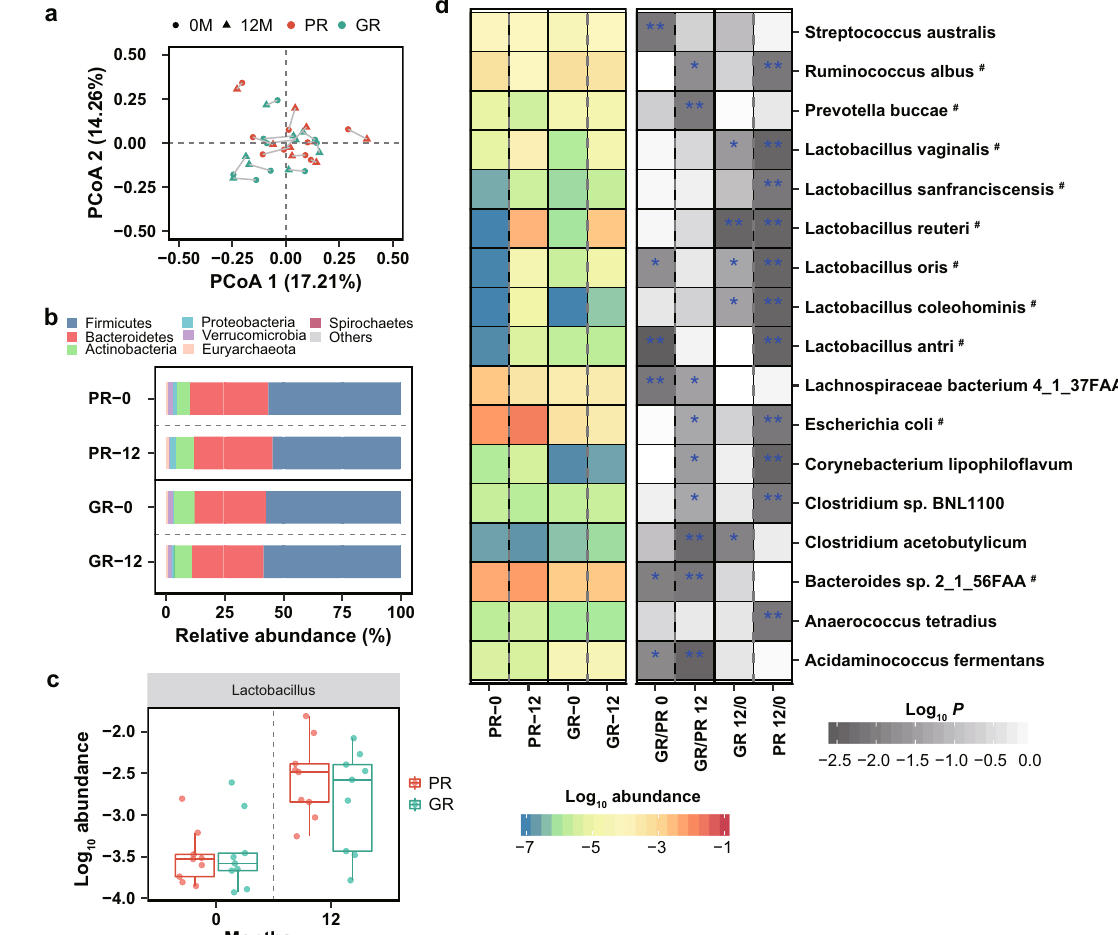
Fig. 2 Compositional differences of the gut microbiota after supplementation with L. reuteri ATCC PTA 6475. a Principal coordinate analysis (PCoA) of microbiota community at species level based on Bray – Curtis distance. The overall microbial composition between the GR ( n = 9) and PR ( n = 9) groups or between the two time points shows no signi fi cant difference, estimated by PERMANOVA analysis. The blue and red colors indicate the GR and PR groups, respectively; The dot and triangle indicate the baseline (0 M) and 12 months (12 M), respectively. b Relative pro fi les of top seven abundant phyla. c Increased abundance of the genus Lactobacillusin in the GR ( n = 9) and PR ( n = 9) groups at 12 months ( P- value < 0.01 by the Wilcoxon signed-rank test). The upper quartile, median and lower quartile are shown in the box plot. The blue and red colors indicate the GR and PR groups, respectively. d The left heatmap shows log-transformed mean abundances of differential species in the two groups at the two time points. The blue and red colors indicate the low and high abundances, respectively; The grey color in the right heatmap indicates P -value of comparative analysis using the Wilcoxon test ; ‘ * ’ denotes P < 0.05; ‘ ** ’ denotes P < 0.01; ‘ # ’ indicates the differential species were also identi fi ed by DESeq2 (adjusted P -value < 0.05 and |log 2 fold change |